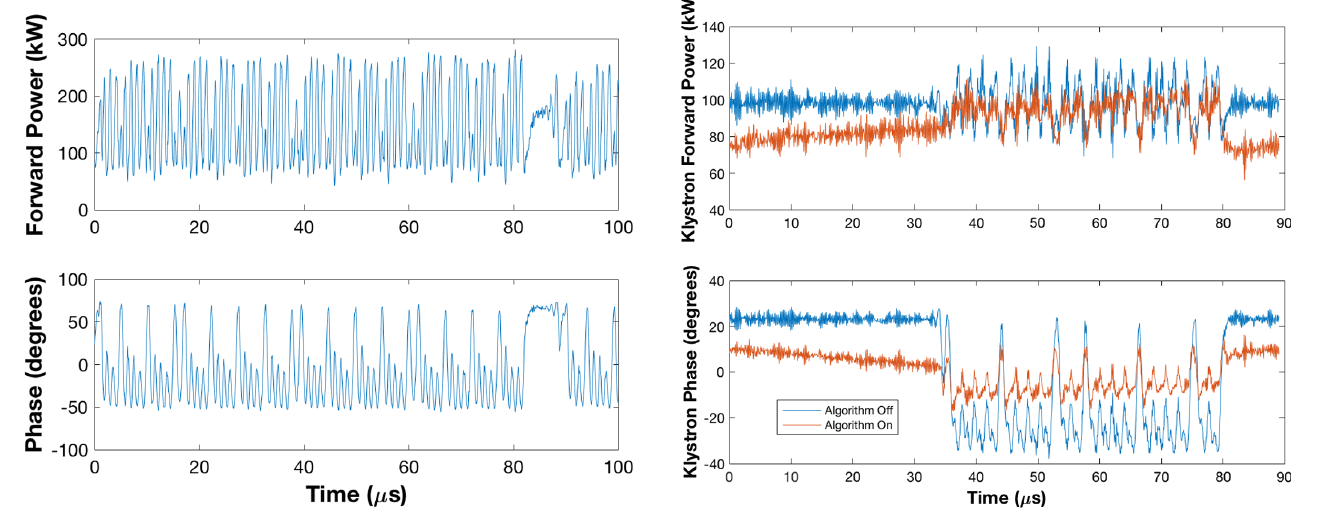
FIG. 2. Klystron power with 2244 bunches, 1 . 2 × 10 11 protons/ bunch, 25 ns spacing, 6.5 TeV.